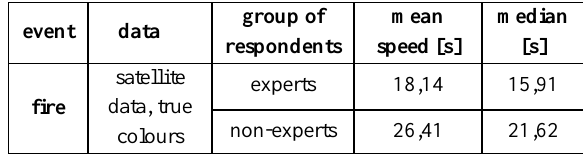
Table 7. The speed of solving problems related to crisis management based on the expert experience of respondents - soldiers, non-soldiers